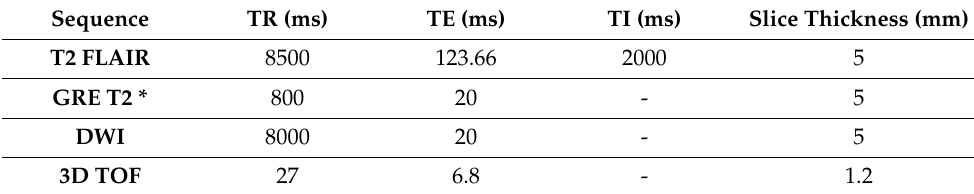
Table 2. Acquisition parameters of magnetic resonance imaging.